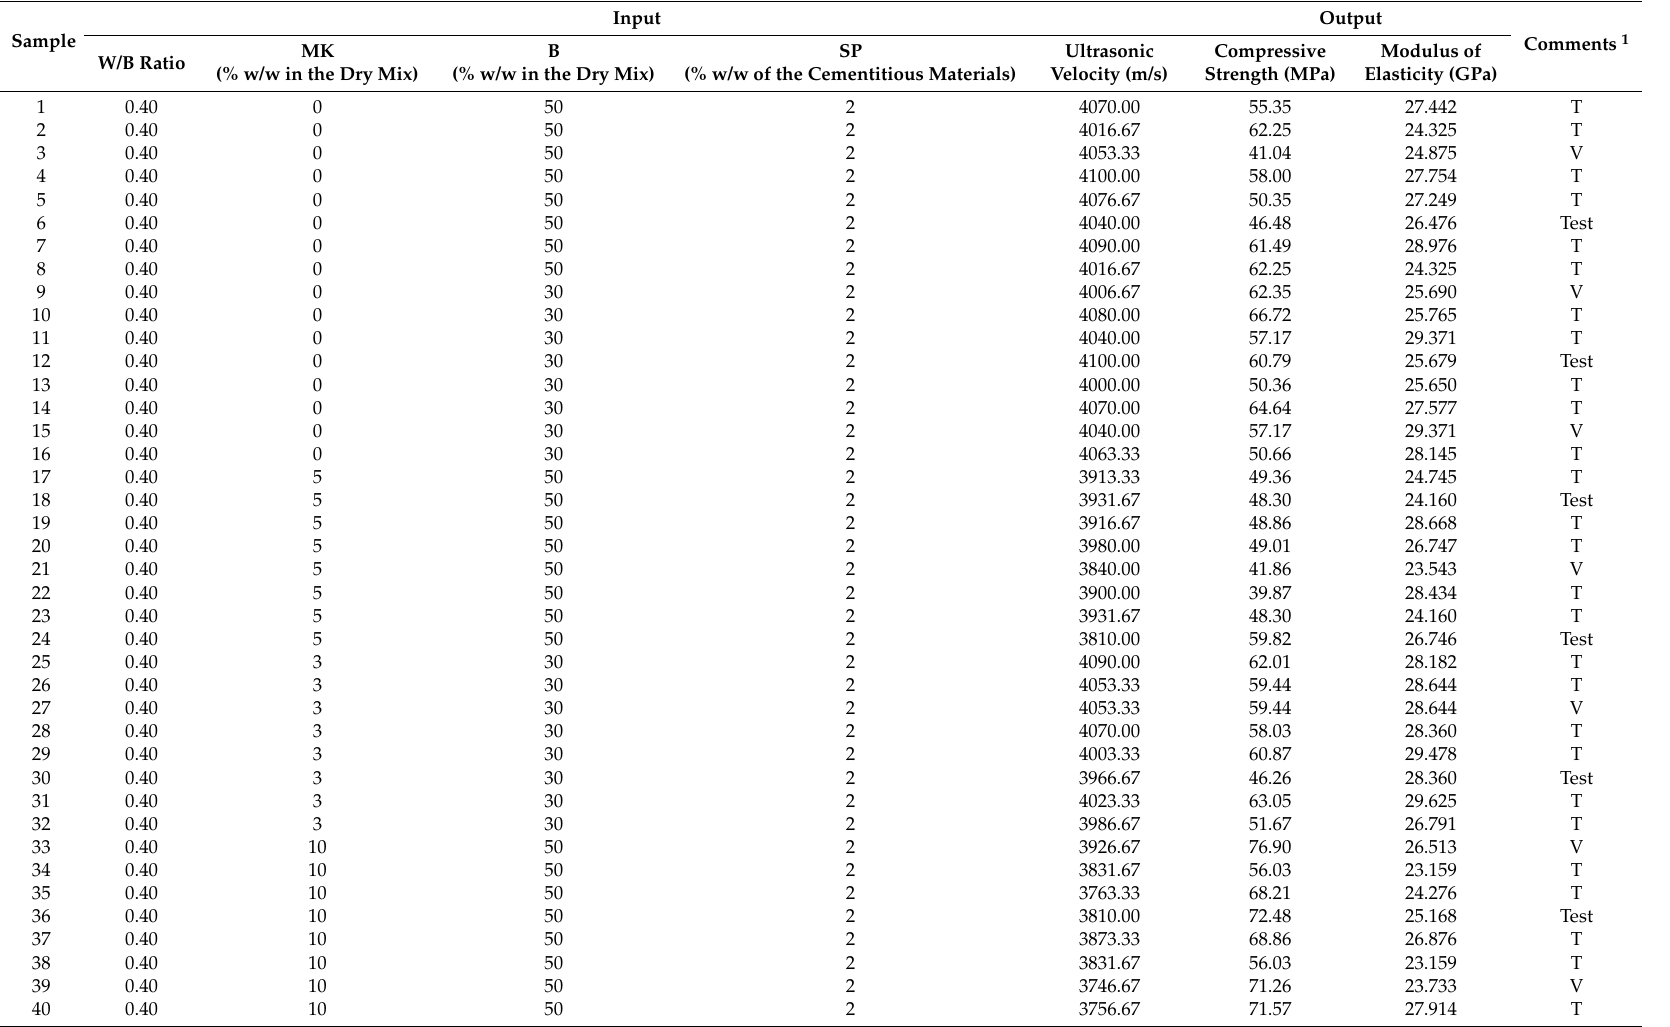
Table 1. Experimental data/results and input and output parameters of